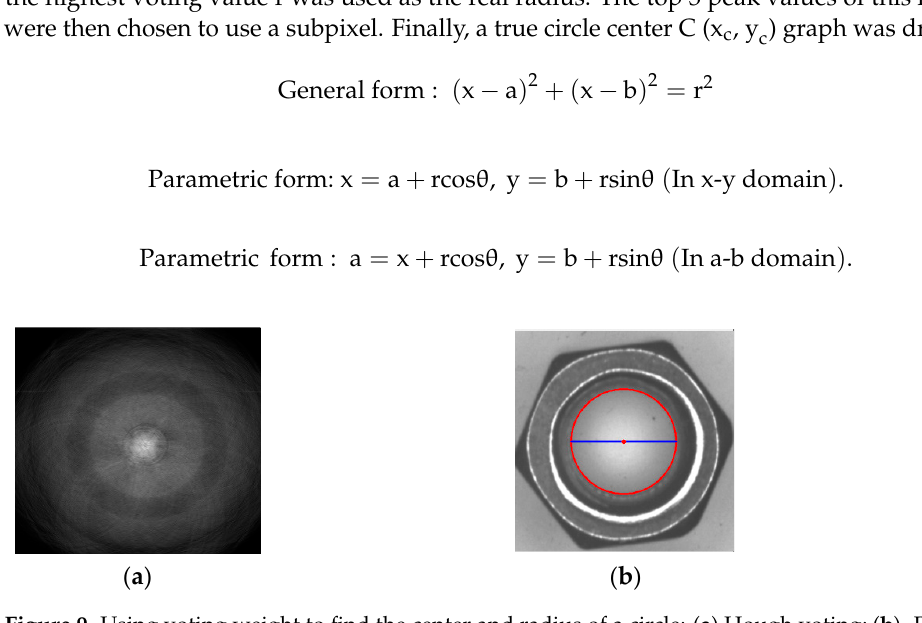
Figure 9. Using voting weight to find the center and radius of a circle: ( a ) Hough voting; ( b ). Radius.